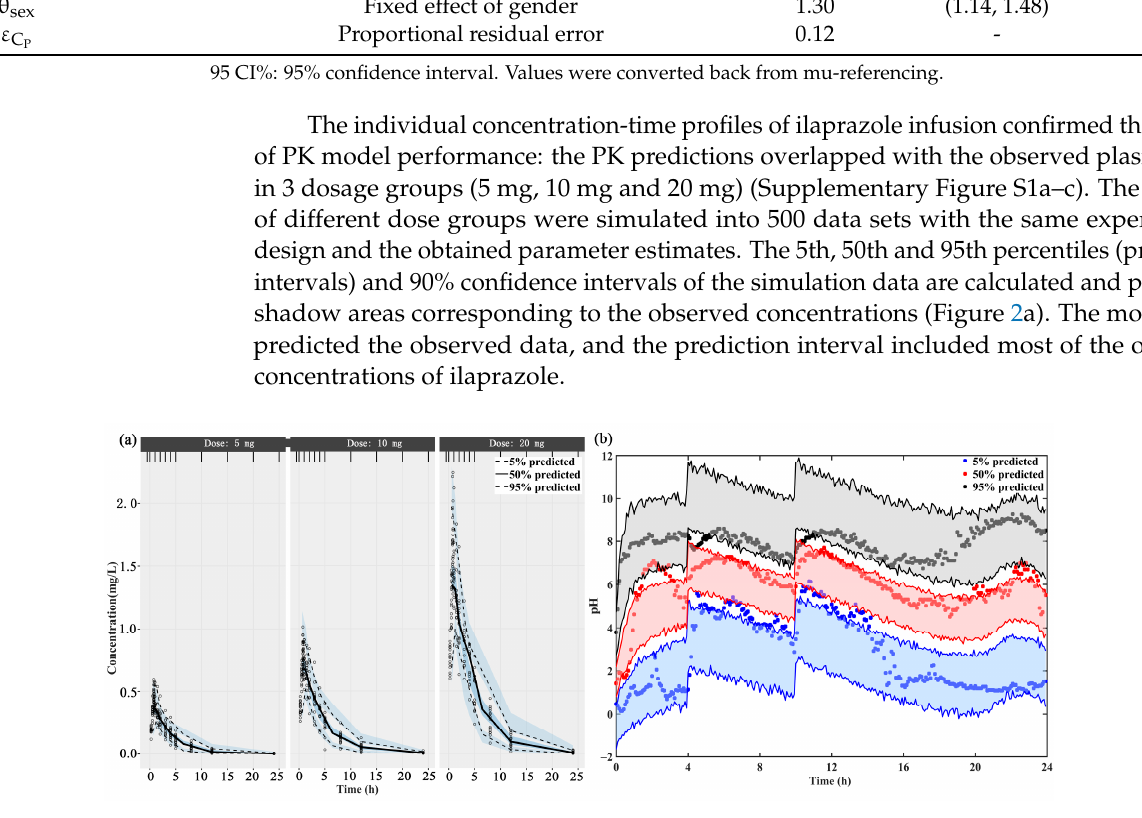
Figure 2. The visual predictive check (VPC) of ( a ) the final population PK model and ( b ) the mechanism-based PK/PD model. The upper, middle, and lower lines represent the 95th percentile, 50th percentile, and 5th percentile, respectively.